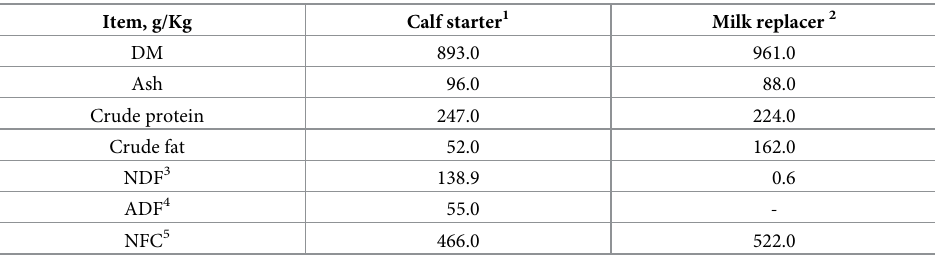
Table 1. Chemical composition of calf starter and milk